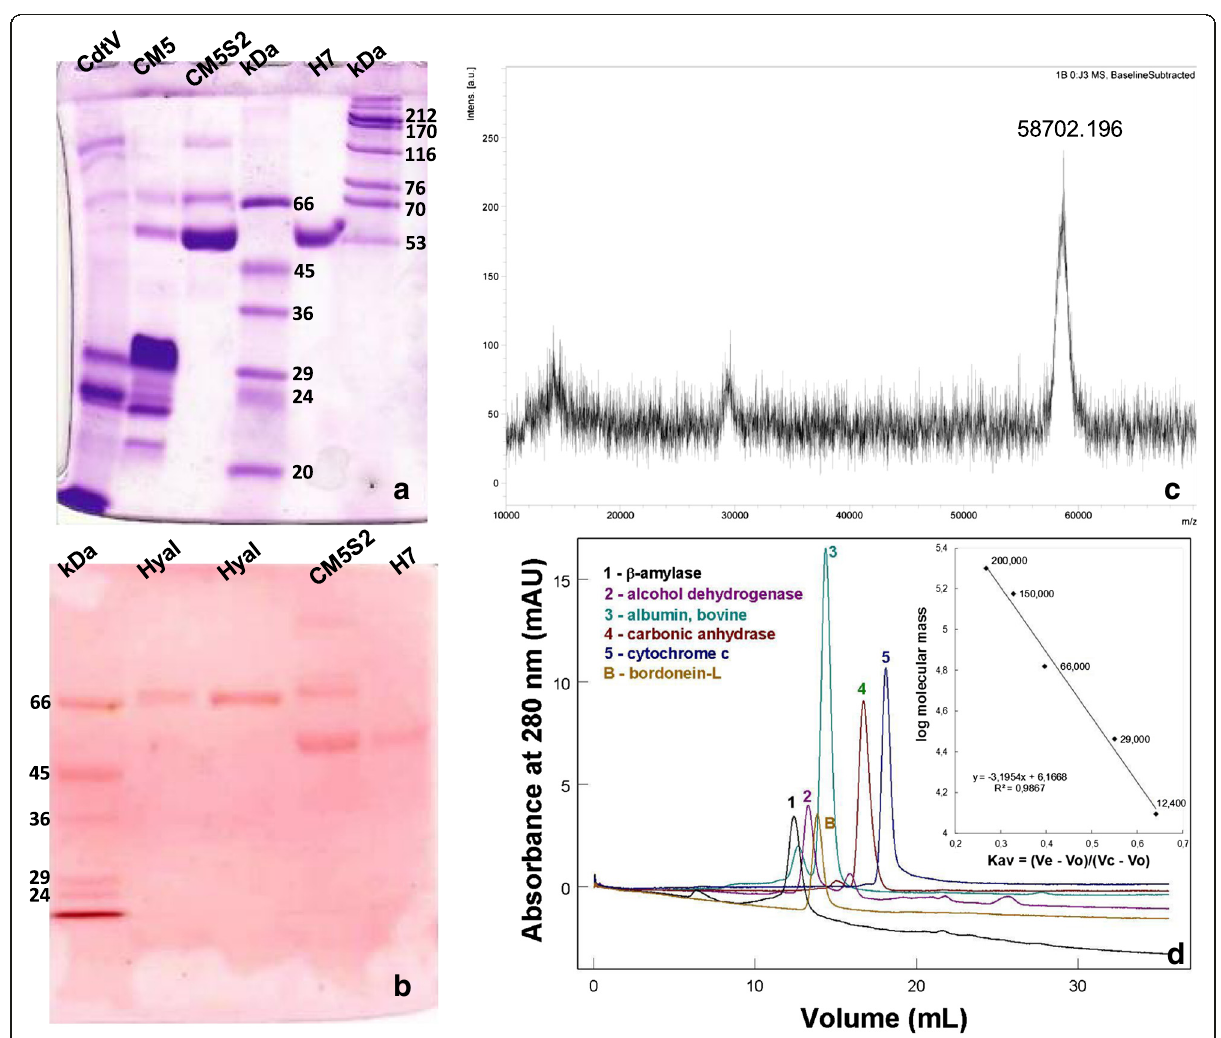
Fig. 2 Determination of molecular mass. a SDS-PAGE (10 %) under non-reducing conditions stained with Coomassie Blue R-350. b SDS-PAGE (10 %) under non-reducing conditions stained with periodic acid-Schiff (PAS) to detect glycoprotein. Hyal: hyaluronidase CdtHya1 (glycoprotein control), H7: bordonein-L. c Mass spectrum of bordonein-L obtained by MALDI-TOF (positive linear mode). d Exclusion molecular of molecular mass standards and bordonein-L (20 μ g/100 μ L) on a Superdex 200 10/300GL (1 × 30 cm) column equilibrated and eluted with 0.05 M sodium acetate buffer containing 0.15 M NaCl, pH 5.5, at a flow rate of 0.5 mL/min. Insert: calibration curve of the Superdex 200 10/300GL column